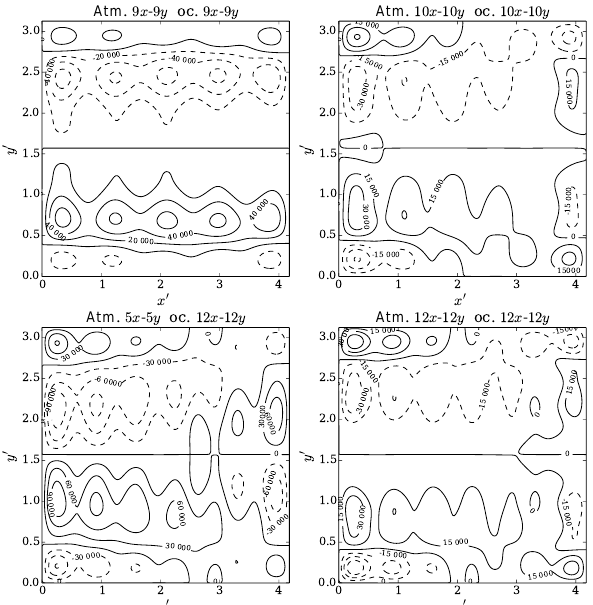
Figure 13. Variance distributions of the ψ o ,i variables in percents for the high-resolution runs. The information on the different run- times is gathered in Table 2.